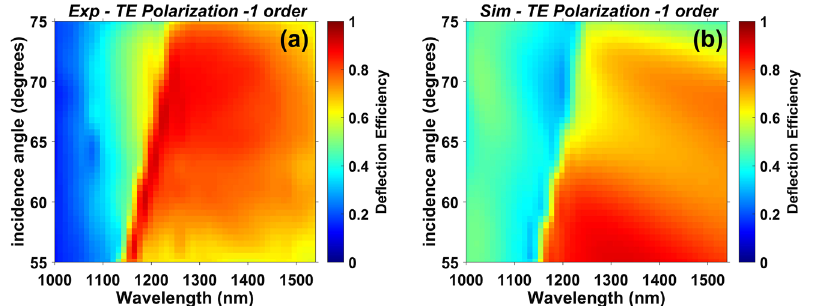
Figure 4: Contour plots presenting (a) experiment and (b) simulation results for − 1st order de fl ection ef fi ciency, r − 1 , as a function of λ and θ , case of TE